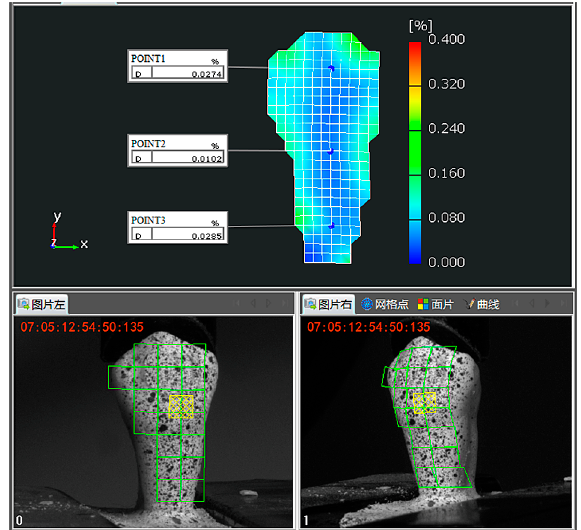
Figure 3. Calculation of full-field buccal surface strains in the software of 3D DIC device. The image marked “0” at the bottom left corner is the image captured by the left camera of the 3D DIC device, while the image marked “1” is the image captured by the right camera of the 3D DIC device. Virtual grids (green square grids) were down-sampled for display purposes.